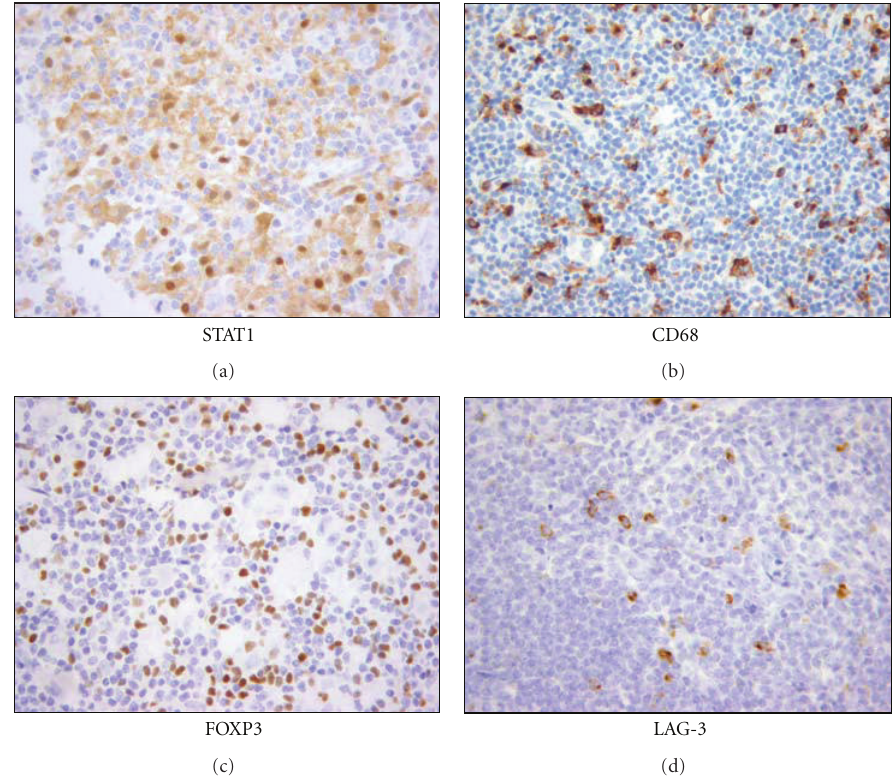
Figure 3: Immunohistochemical staining of immunosuppressive cells in HL: tumor-associated macrophages TAM (STAT-1 and CD68) and regulatory T cells (FOXP3 and